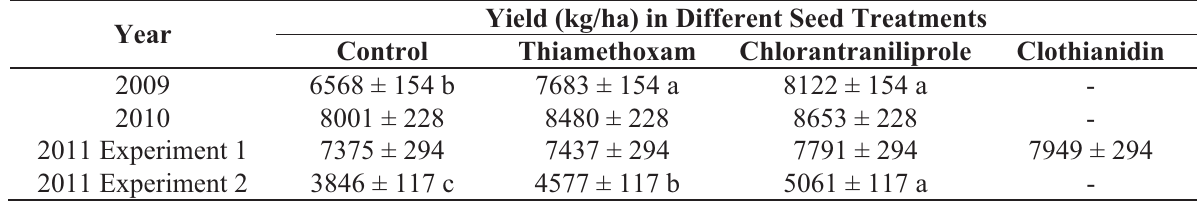
Table 5. Impact of seed treatments on yields from small plot field experiments during 2009–2011 a